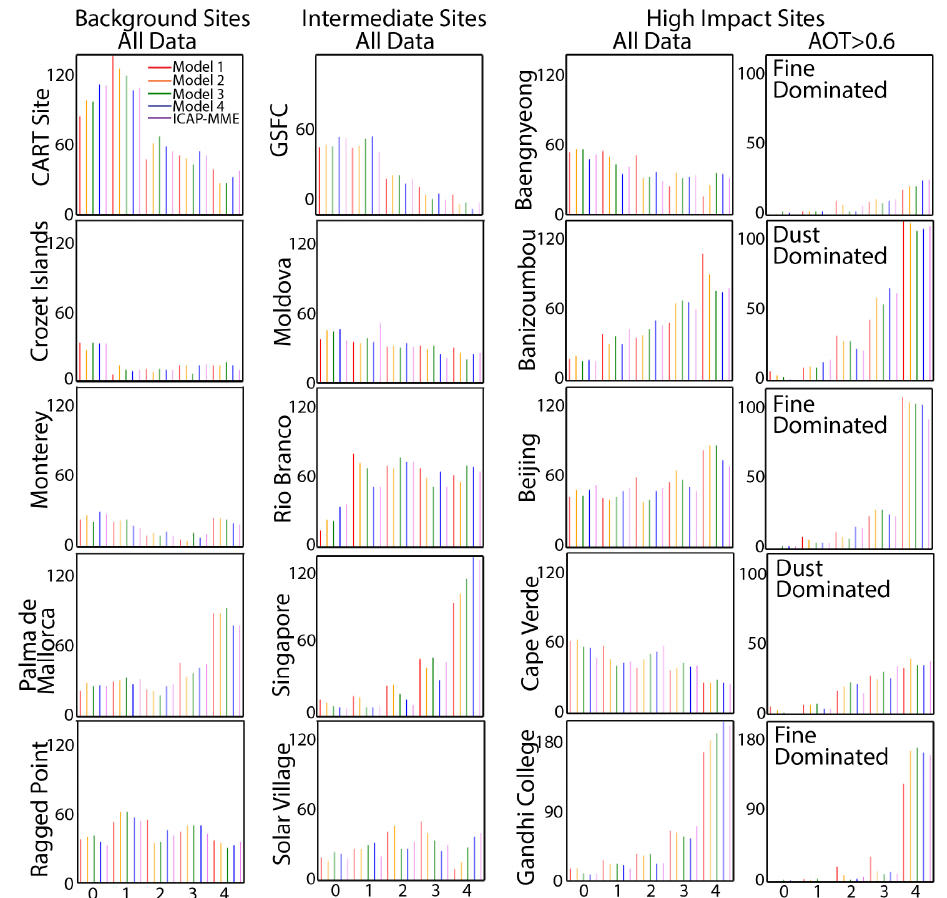
Figure 11. Rank histograms for selected sites the entire 1-year study period. Included are sites considered as background or long range receptor sites (column 1), sites with intermediate loadings (column 2), and sites with high aerosol impact, segregated into all data (column 3) and those cases with AERONET AOT>0.6 (column 4). The dominant aerosol type leading to AOTs>0.6 are listed for sites in column